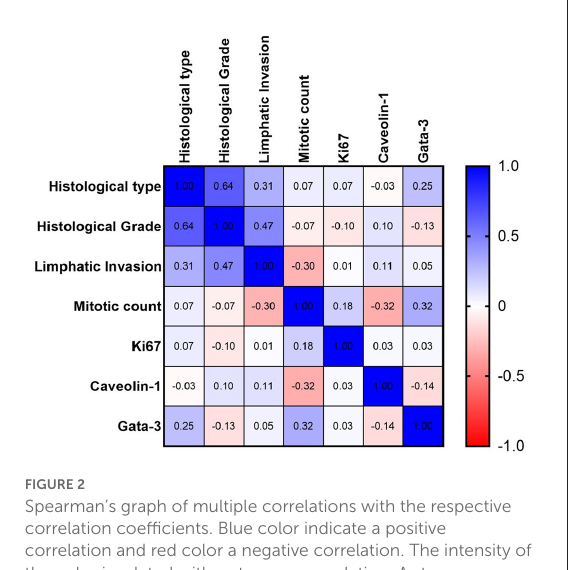
FIGURE2 Spearman’s graph of multiple correlations with the respective correlation coefficients. Blue color indicate a positive correlation and red color a negative correlation. The intensity of the color is related with a stronger correlation. A strong correlation between histological grade and histological type and a moderate negative correlation between mitotic count and Caveolin-1 expression are